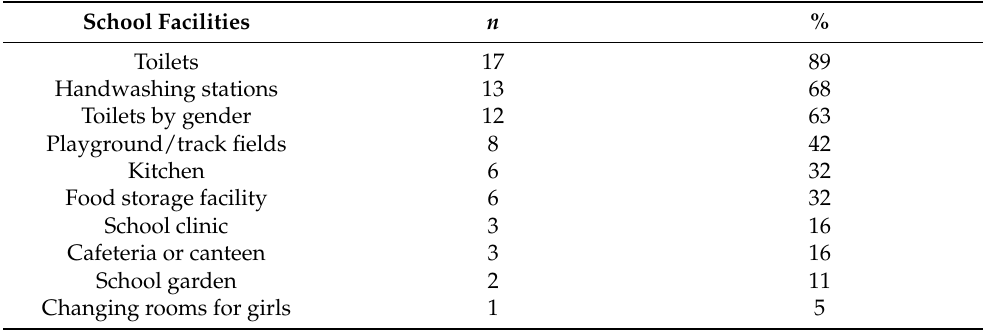
Table 5. Available school facilities as reported by the school administrators for 19 junior secondary